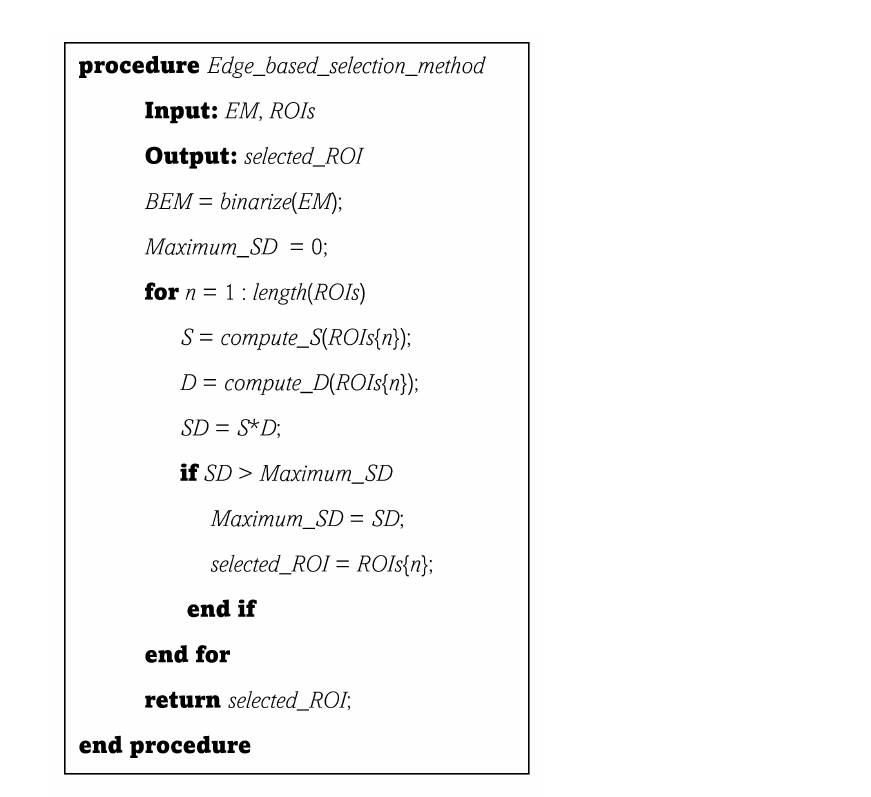
Figure 2. A procedure that summarizes the processes of employing the proposed edge-based selection method to analyze the ROIs generated by different deep learning object-detection models and select the ROI that enables the effective detection of the region that contains the